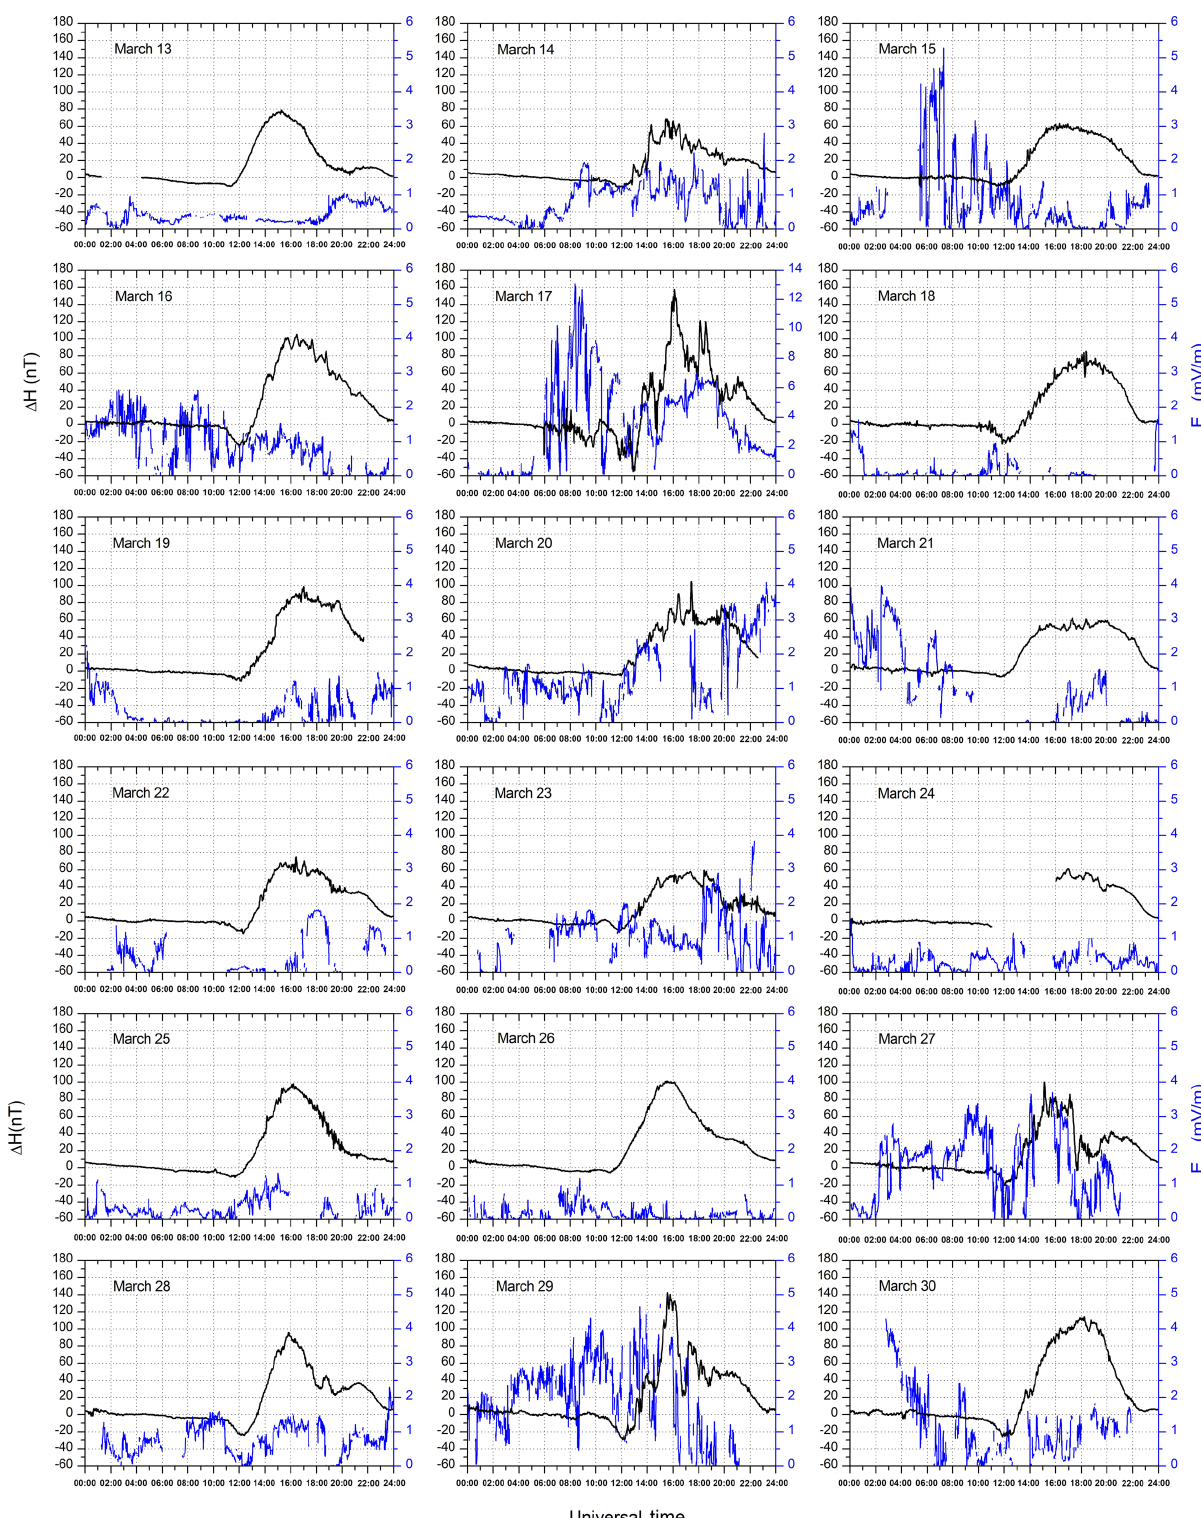
Figure 6. (cid:49) H Jicamarca–Piura (black line) and IEF E rec (blue line) from 13 to 30 March, showing the occurrence of